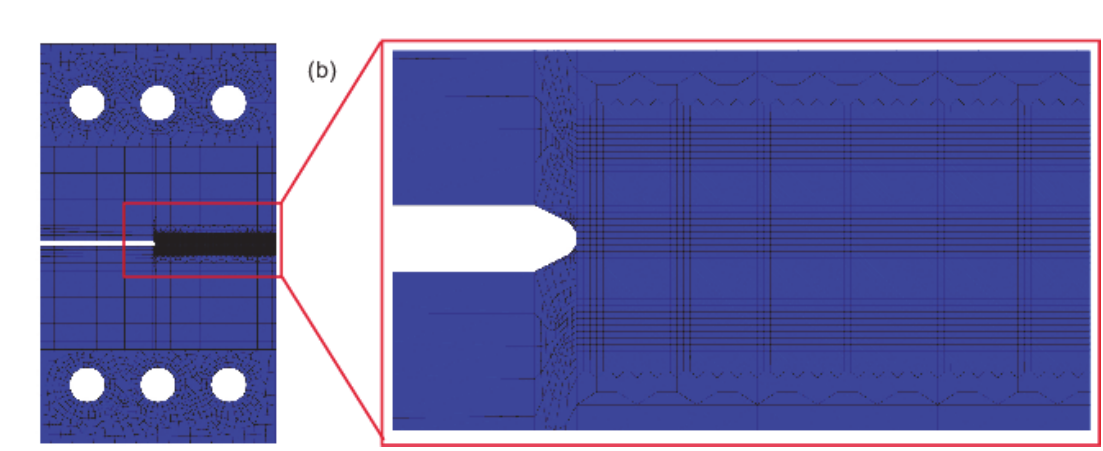
Figure 1: (a) FEM model (b) Mesh around the crack